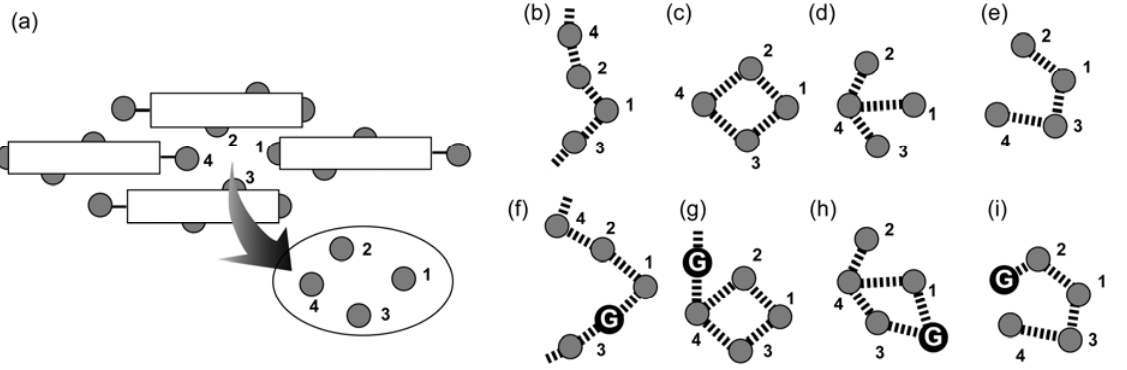
Figure 3. Association among four hydrogen bonding groups of four host molecules (a). Four kinds of hydrogen bonding networks; linear (b), cyclic (c), branched (d), and arched (e). The networks involving guest components; linear (f), cyclic (g), branched (h), and arched (i).